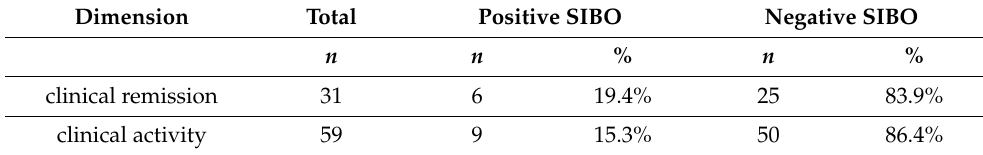
Table 3. IBD patients with positive SIBO in accordance with their clinical activity status.